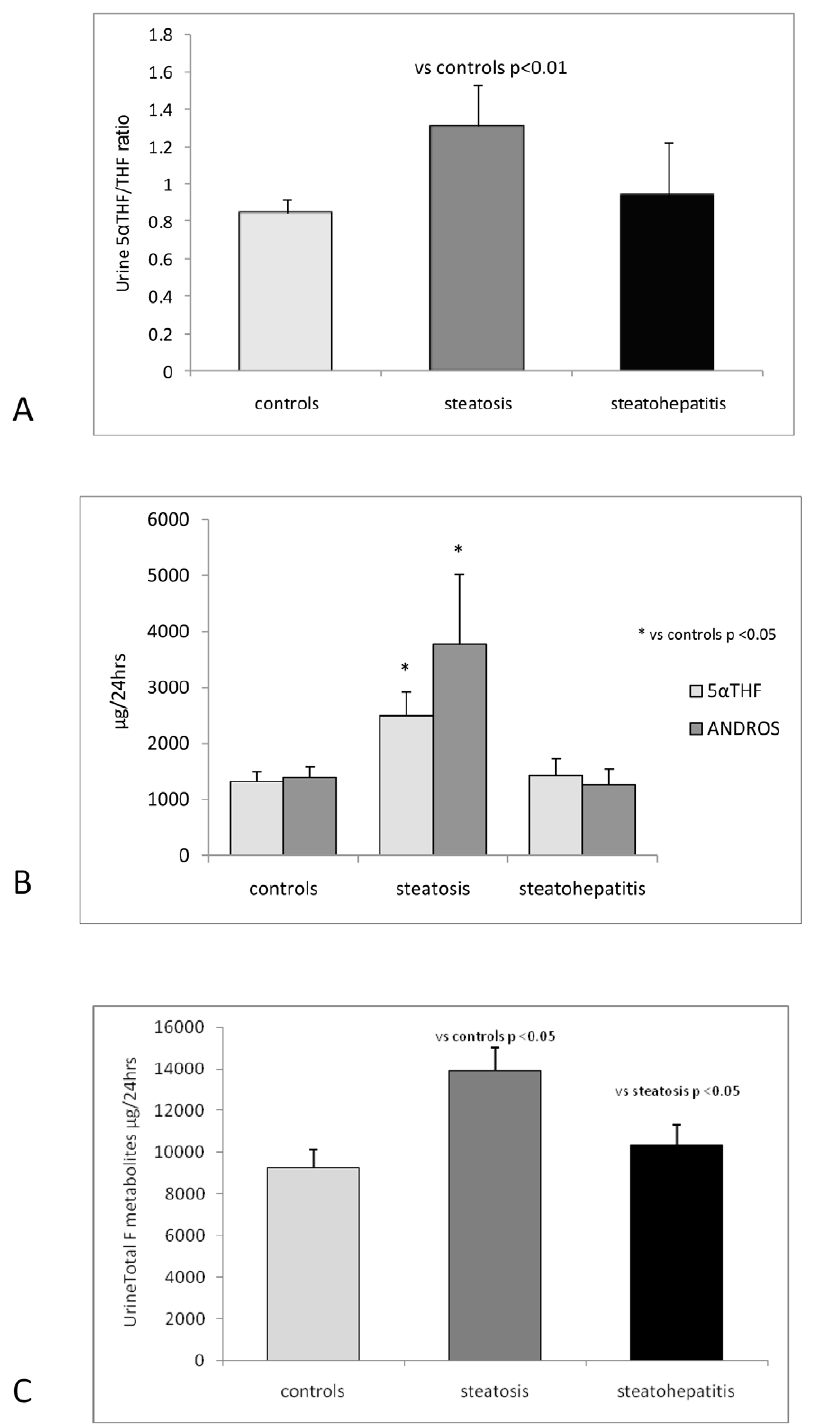
Figure 1. 24 hour urine steroid metabolite analysis from patients with steatosis and steatohepatitis compared with obese controls. (A): 5 a -reductase activity as depicted by the urinary 5 a THF/THF ratio (mean 6 SEM). (B): total 24 Urine 5 a -reduced metabolites (mean 6 SEM) (Andros: androsterone). (C): total 24 hr Urine F metabolites (mean 6 SEM).